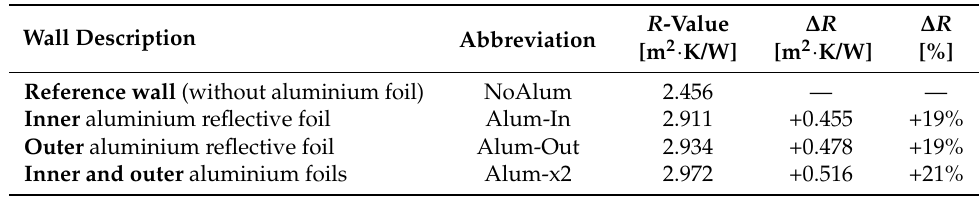
Table 5. Measured thermal resistance of double-pane LSF walls and thermal performance improve- ment due to aluminium reflective foils.